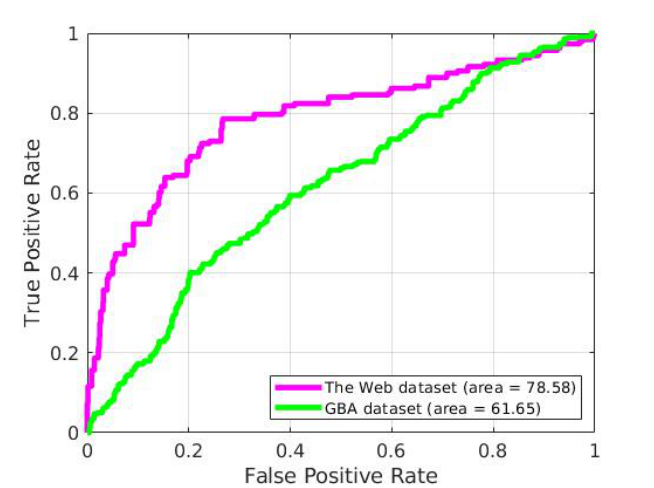
Figure 4. ROC of the proposal for GBA and The Web